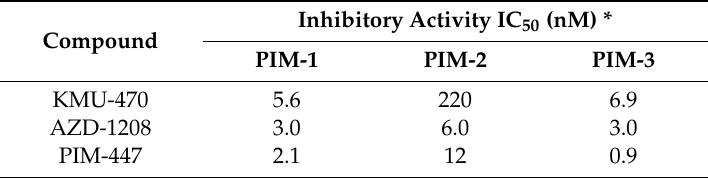
Table 1. PIM kinase inhibitory activities of KMU-470.